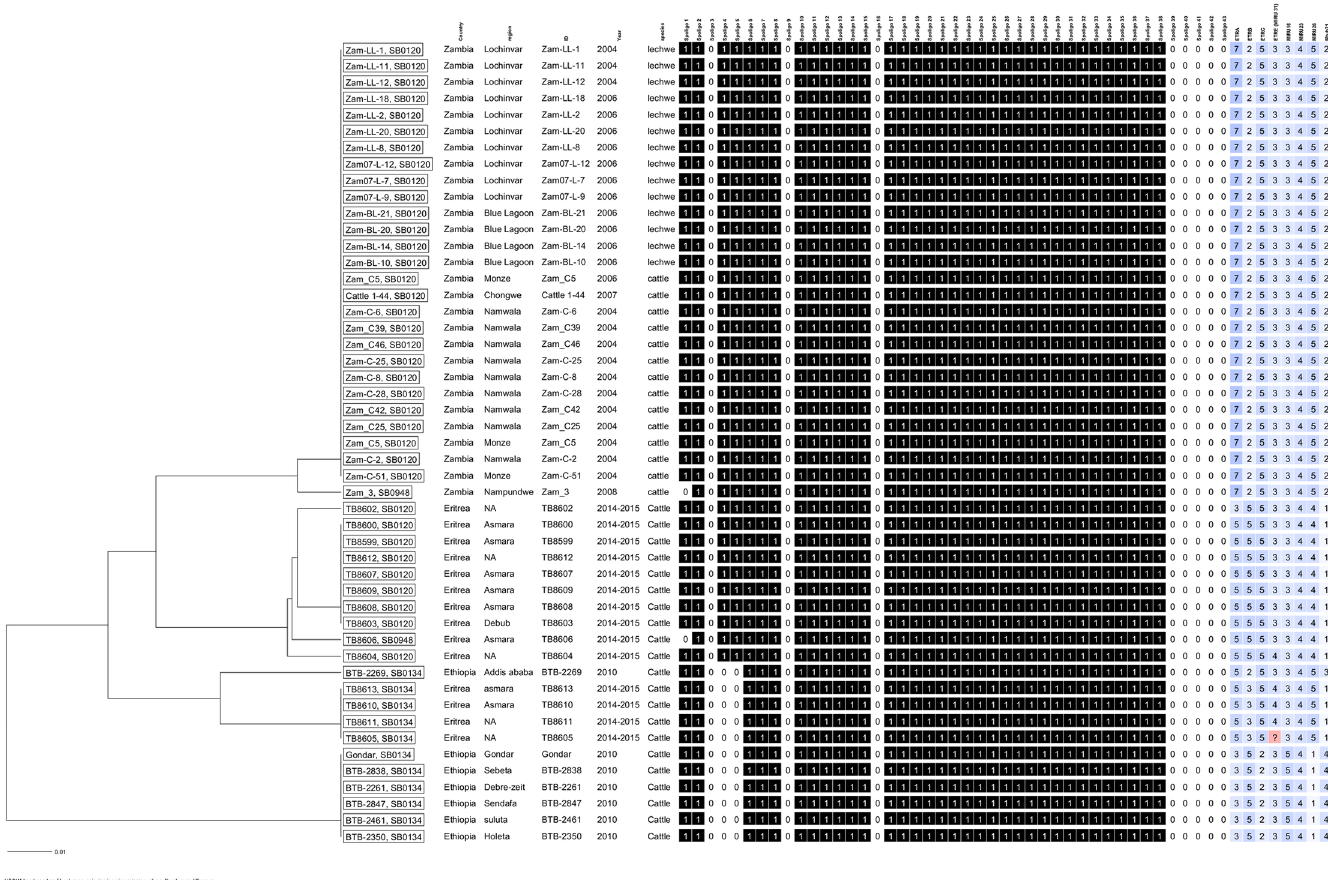
Fig 3. African comparison of spoligo patterns and VNTR profiles showing common traits with the Eritrean